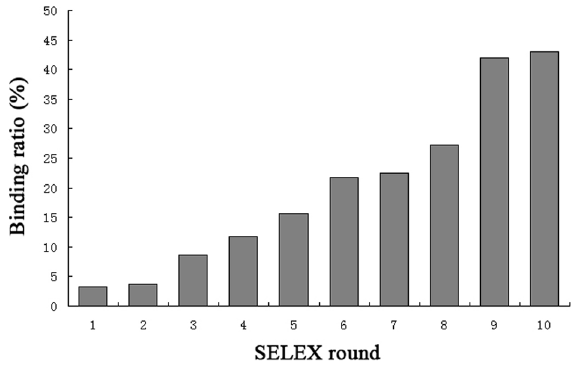
Figure 1. Binding affinity of ssDNA pools of each round of selection. Ten nM of ssDNA pool was incubated with 100 nM of b - BuTx and the ratio of ssDNA bound to b -BuTx was determined by nitrocellulose filter binding assay.